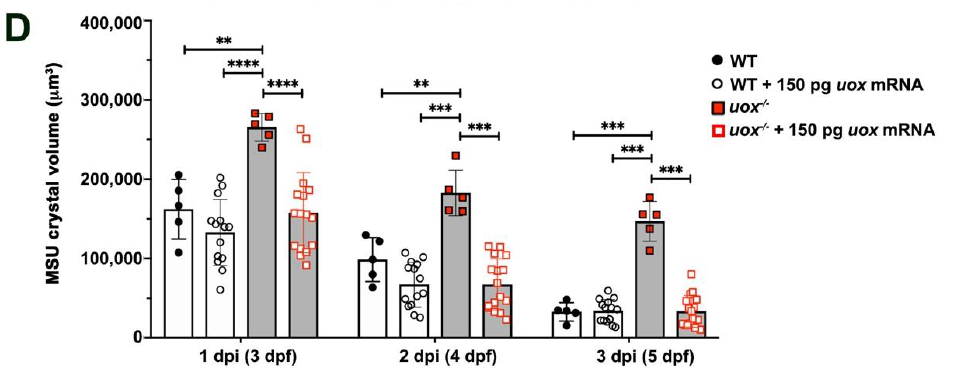
Figure 4. Microinjected MSU crystals persist in uox − / − larvae. ( A ) Representative confocal imaging (transmitted light views, Z-projections) of WT and uox − / − larvae at 1, 2, 3 and 4 days post-injection (dpi) with MSU crystals into the hindbrain ventricle (injected at 2 days post fertilization (dpf)). A cyan border outlines MSU crystals. ( B ) A representative reflection image of MSU crystals in a WT larva at 1 dpi (same larva as in ( A )), pseudo-coloured in cyan. The lower panel shows a standard deviation Z–projection of the binary mask in black and white. ( C ) Quantification of MSU crystals ( µ m 3 ), as detected in ( B ), within individual WT (white bars) and uox − / − (grey bars) larvae at 1, 2, 3 and 4 dpi (3, 4, 5 and 6 dpf, n = 15 larvae per group). Statistical significance determined using multiple unpaired Student’s t-tests with Holm–Sidak correction. ( D ) Quantification of MSU crystals ( µ m 3 ) within individual WT (white bars) and uox − / − (grey bars) larvae at 1, 2 and 3 dpi (3, 4 and 5 dpf) and within WT (white bars) and uox − / − (grey bars) larvae injected with 150 pg uox mRNA ( n = 5 and 15 larvae per group for the non-mRNA-injected and mRNA-injected groups, respectively). Statistical significance determined using a 2-way ANOVA and Tukey’s multiple comparisons test. Error bars in ( C , D ) represent means ± SDs. * p < 0.05, ** p < 0.01, *** p < 0.001 and **** p < 0.0001. Scale bar 100 µ